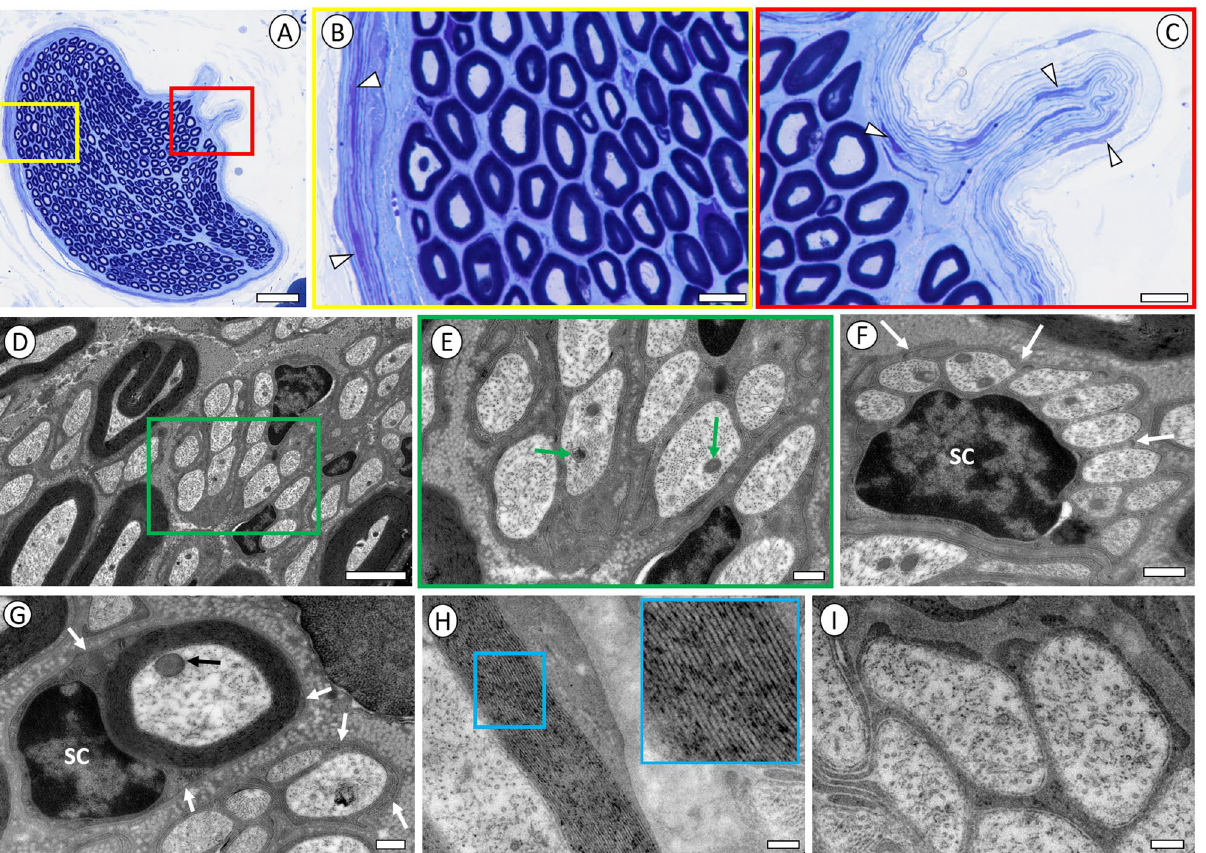
Figure 2. Light and electron micrographs of human cervical vagus nerve. ( A ) LM overview of representative fascicle from the cervical vagus nerve in 45 year old female. Scale bar = 50 µm. ( B , C ) Detailed view of yellow and red boxed areas in ( A ). Note lamellar organization of perineurial cells with epithelioid features forming multiple concentric layers and adjacent myelinated fibers. Small axonal bundles branching off the distal cervical vagus nerve may innerve thoracic target, including cardiac structures. Scale bar in B,C = 10 µm. Electron micrographs in ( D – G ) were obtained from same female subject as in ( A – C ). ( D ) Representative view of a mixed collection of myelinated and unmyelinated axons in the cervical vagus nerve. Scale bar = 2 µm. ( E ) Higher magnification of green box area in ( D ). Note well-preserved cytoskeleton, including microtubules and neurofilaments, and mitochondria (green arrows). Scale bar = 0.4 µm. ( F ) Remak bundle formed by Schwann cell (SC) and group of unmyelinated axons. Note basal lamina surrounding the Schwann cell plasma membrane (white arrows). Scale bar = 0.5 µm. ( G ) Schwann cell nucleus (SC) and associate myelinated axon. Note basal lamina surrounding the plasma membrane of myelinating Schwann cell and of adjacent Remak bundle. Scale bar = 0.4 µm. ( H ) Detail of myelin sheath with close-up view of area in blue box from cervical vagus nerve in a 49 year old male. Note integrity of myelin with lamellar wall structure and preservation of spacing between membrane layers. Scale bar = 0.2 µm. ( I ) Close-up view of unmyelinated axons in same subject as in ( H ) Note excellent preservation of microtubules, neurofilaments, plasma membrane, and surrounding basal lamina specialization. Scale bar = 0.2